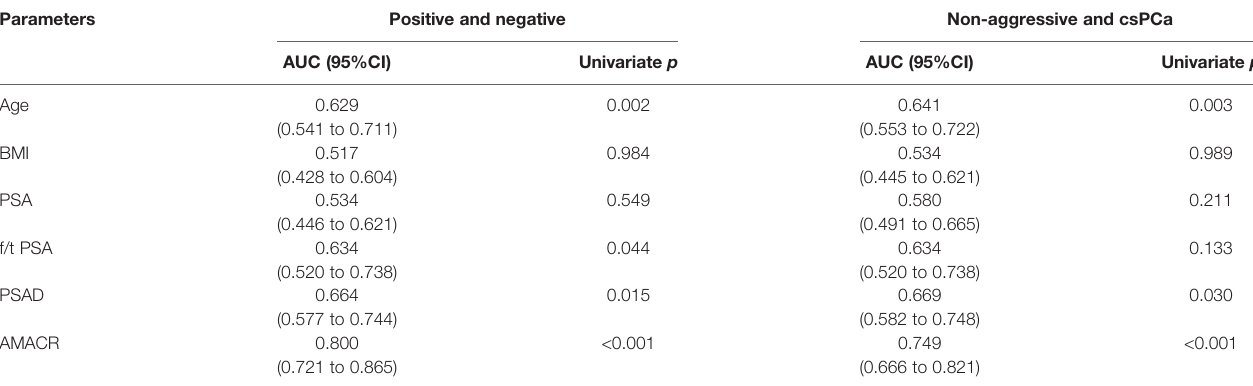
TABLE 3 | The performance of urine exosomal AMACR and clinical features to predict biopsy results in the validation cohort. Parameters Positive and